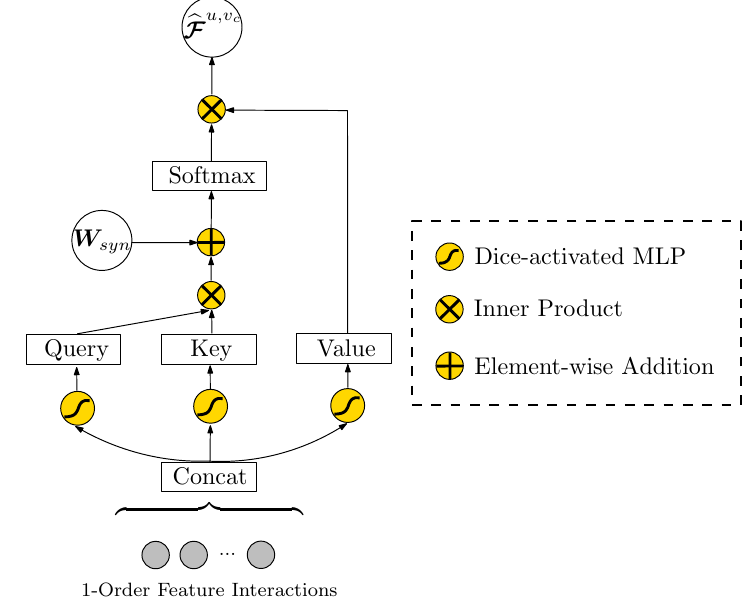
Figure 2. Synthesizer